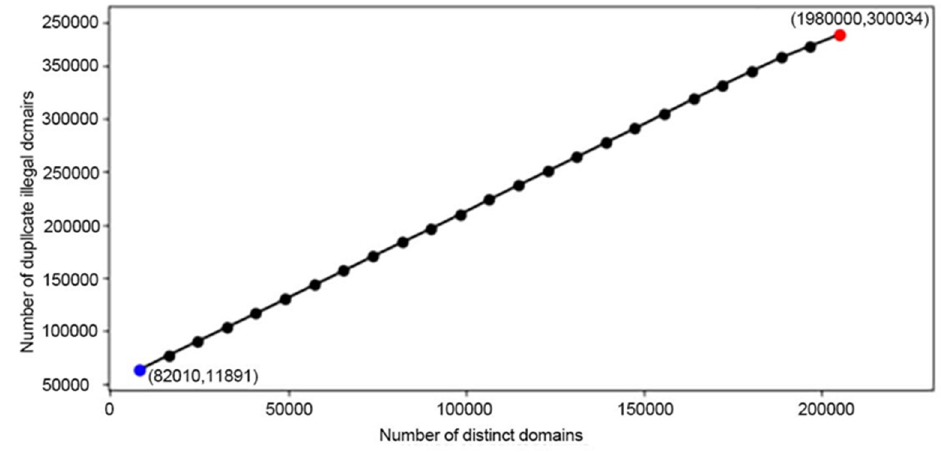
Figure 10. Changes in the number of new illegal domain names included when different numbers of domain names are generated.